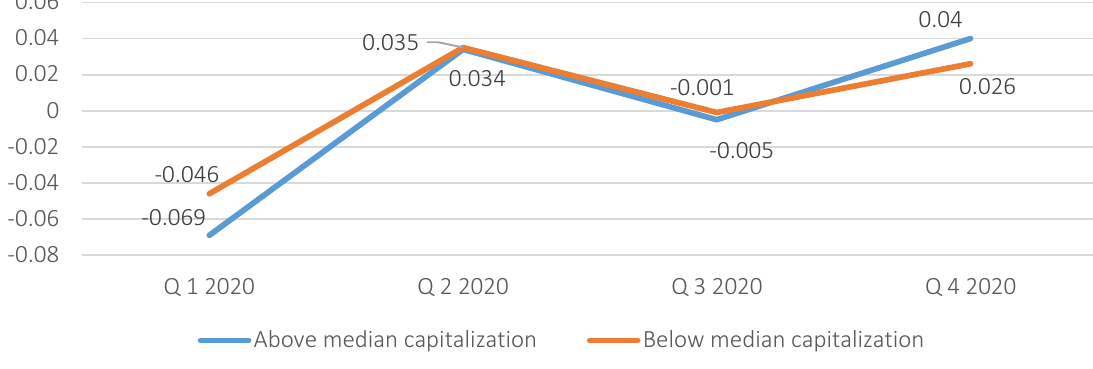
Figure 1. Bank loan